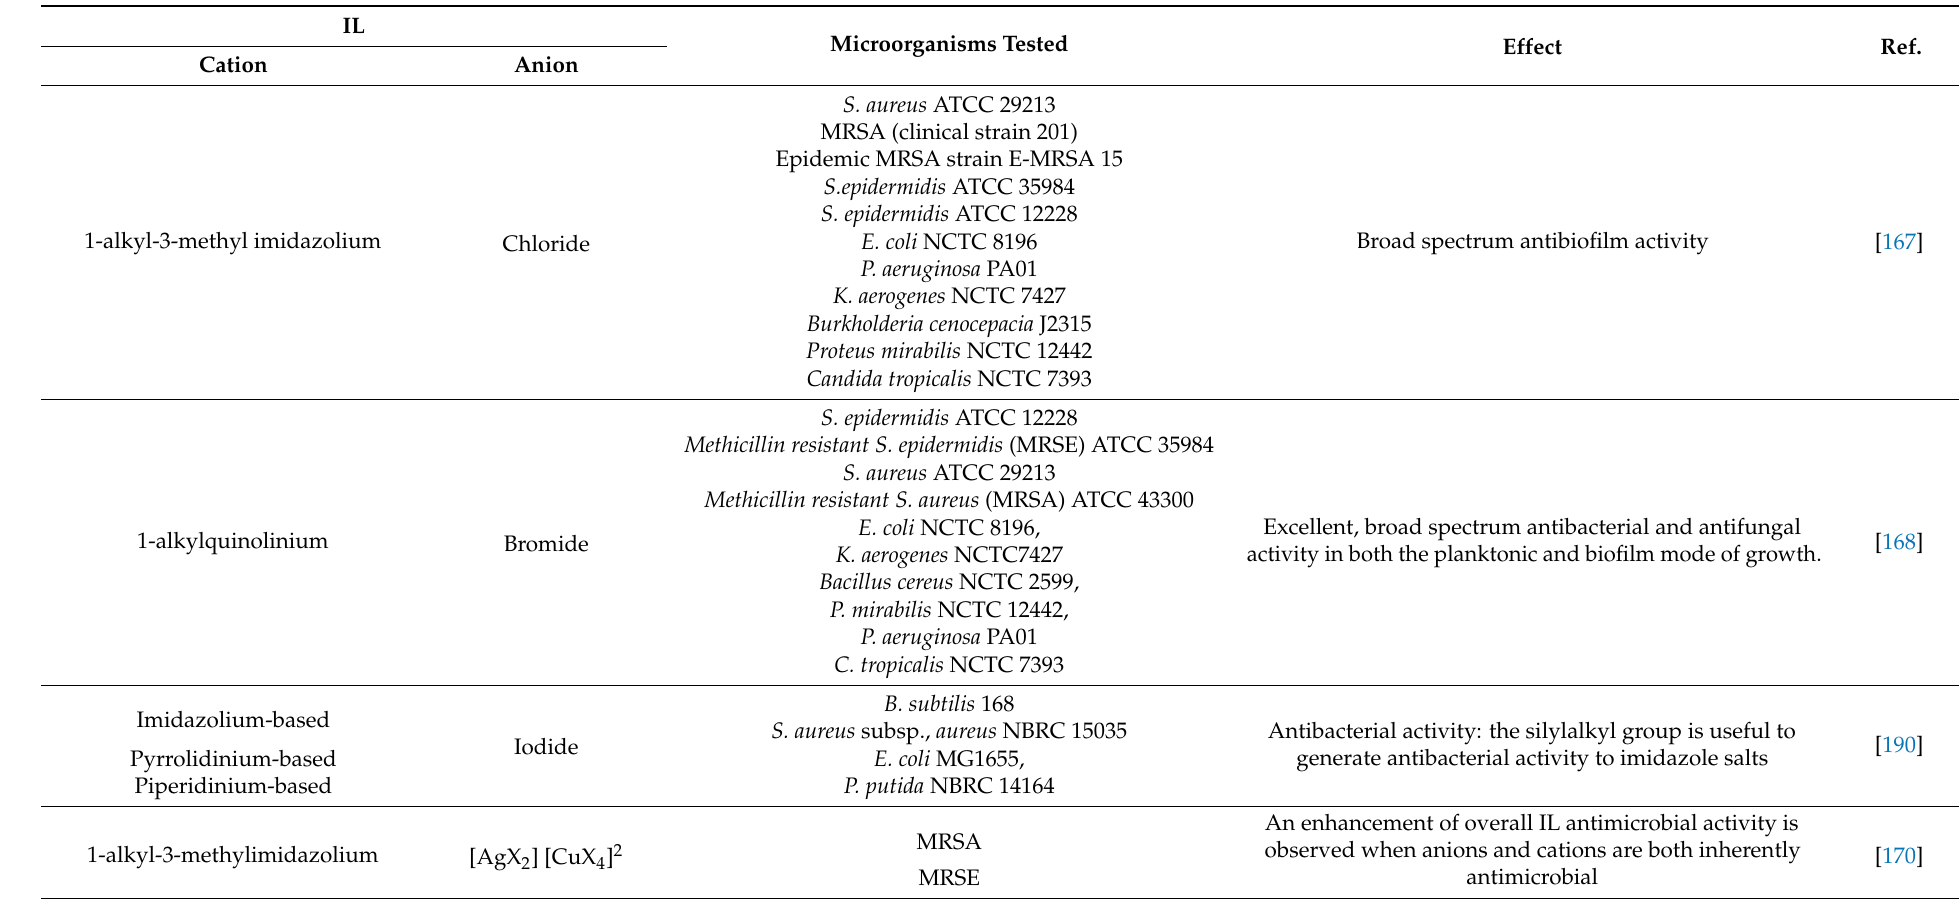
Table 4. Antimicrobial ionic liquids and their effect on